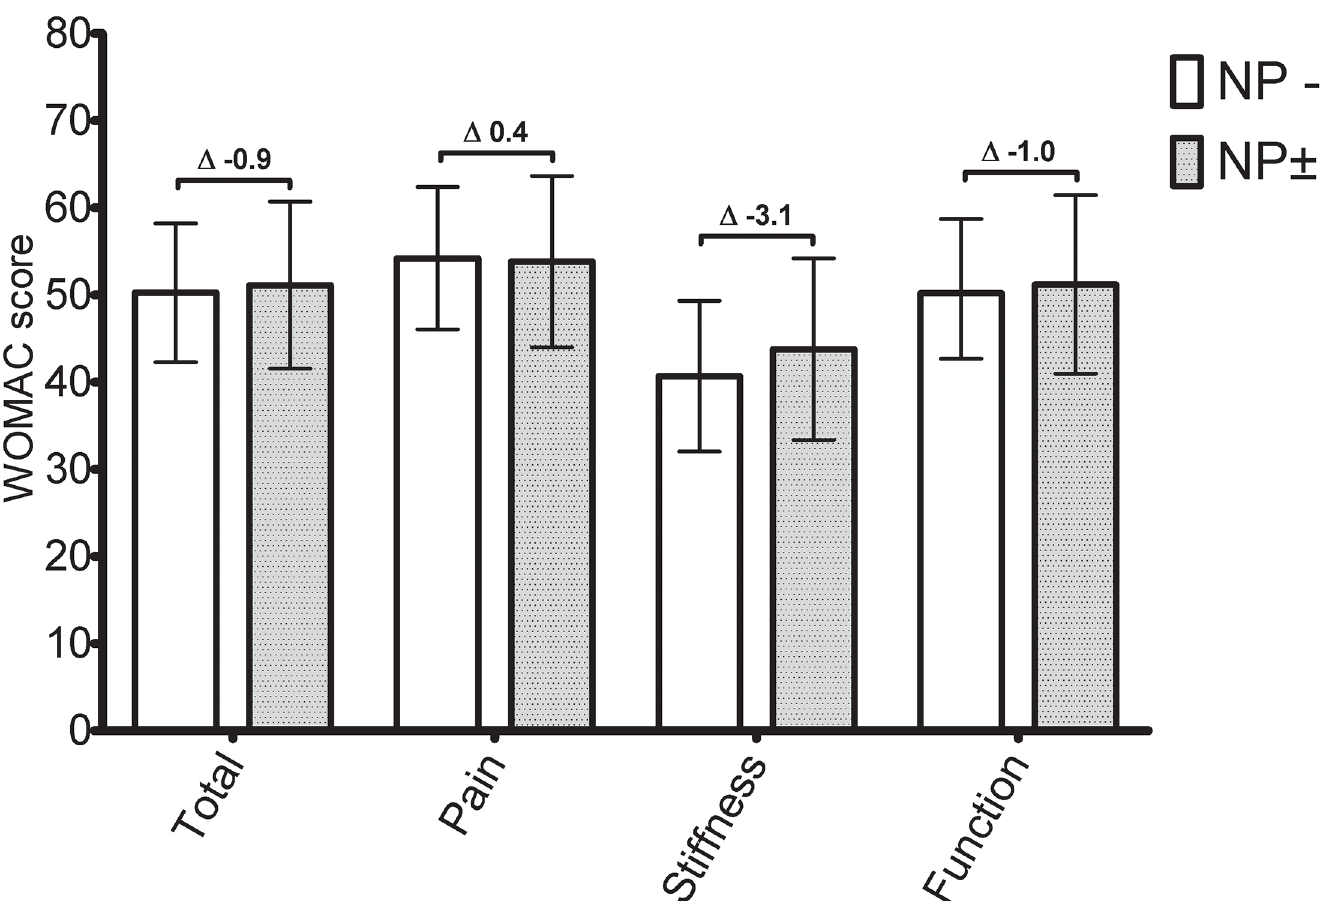
Fig 2. Hip OA Model 3: Fully ANCOVA adjusted WOMAC scores. NP-: unlikely neuropathic pain phenotype (mPDQ (cid:20) 12). NP ± : possible neuropathic pain phenotype (NP ± , mPDQ > 12). WOMAC score 100 indicates no symptoms/problems and 0 indicates extreme symptoms/problems. Error bar represents the 95% CI (lower-upper limits) of the adjusted mean. Mean adjusted difference is displayed numerically. (cid:3) : p < 0.05.